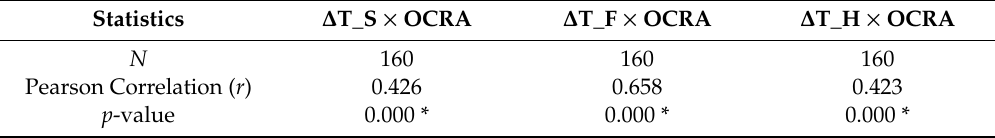
Table 9. Correlation Coe ffi cient and Significance of ∆ T x OCRA per region of interest (ROI).